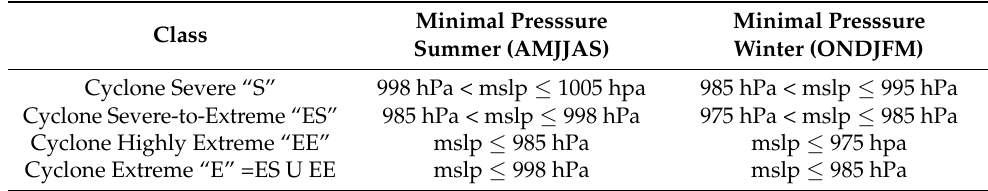
Table 3. Classes of cyclone severity.